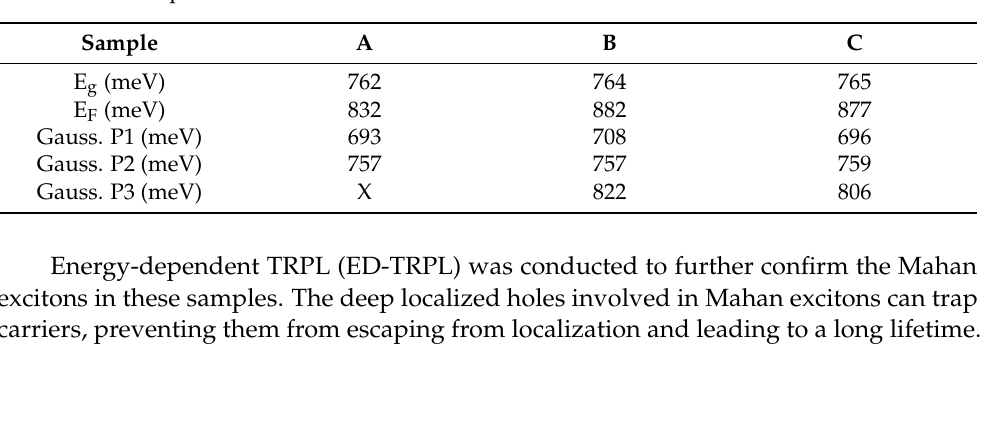
Table 2. Fitting results of the combination of Equation (1) and multiple Gaussian function. The energy values were all represented in